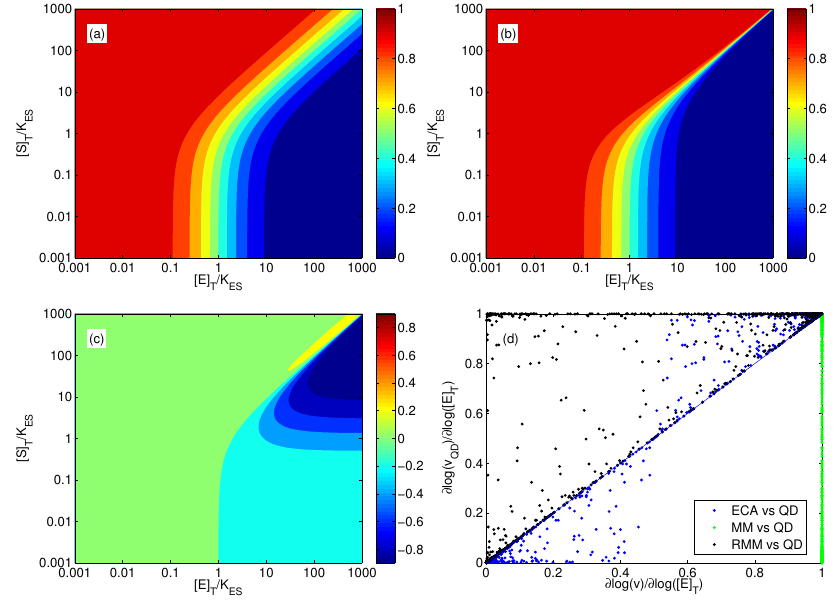
Figure 3. Similar to Fig. 1, but the sensitivity is evaluated against the total enzyme concentration [ E ] T .